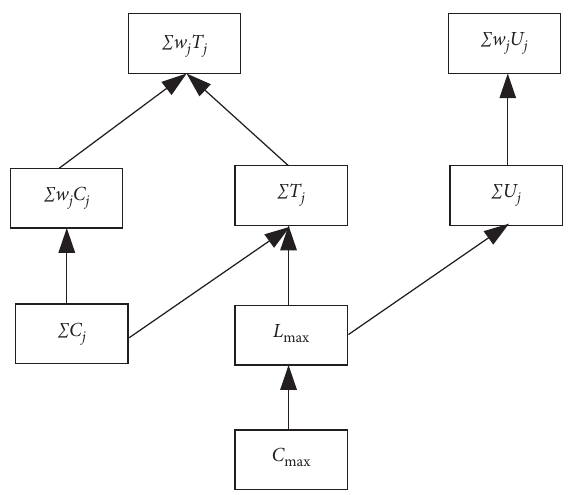
Figure 2: Basic reductions between objective functions in